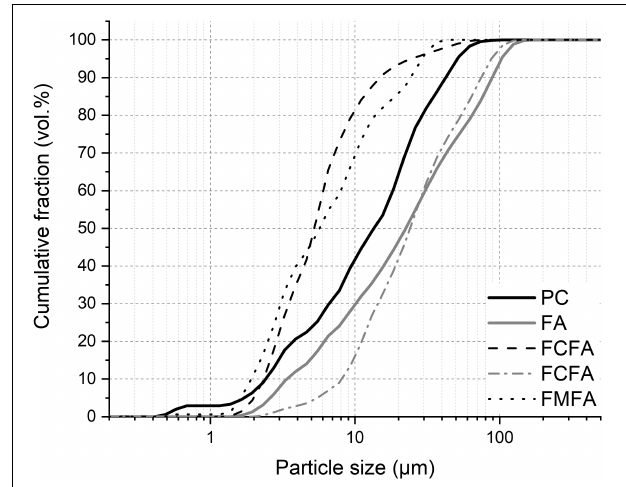
FIGURE 1 | Particle size distribution of the fly ash (FA) materials and the Portland cement measured by laser